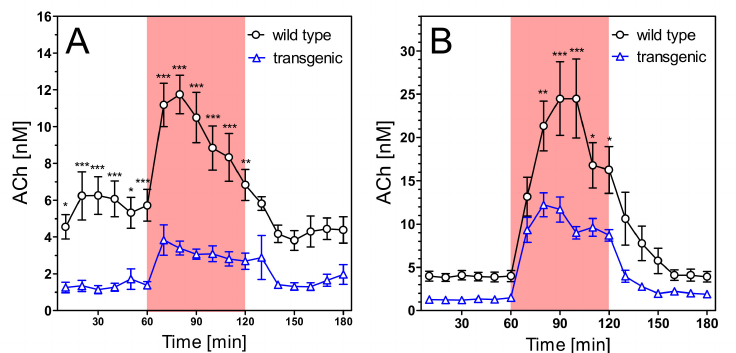
Figure 7. Extracellular ACh concentrations in hippocampus of 6–7 months old wild-type and transgenic rats during open field test ( A ) and under scopolamine perfusion ( B ). The red area represents the intervention (open field exposure or scopolamine perfusion) from 60–120 min. Data are means ± SEM ( n = 7) and were analysed by two-way ANOVA for genotype as variable followed by Bonferroni’s multiple comparison test: ( A ) F1,204 = 6.32, p < 0.001. ( B ) F1,204 = 4.6, p < 0.01. * p < 0.05, ** p < 0.01, *** p <